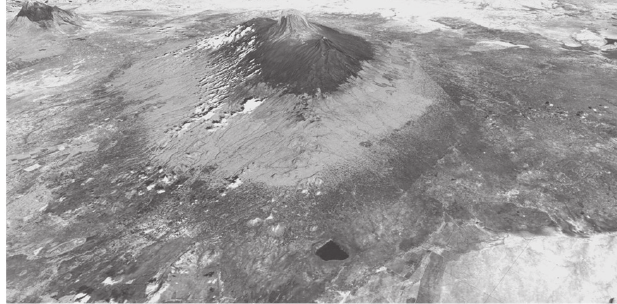
Figure 1. Lake Challa occupying a volcanic caldera, of 2.7 km diameter, at 840 m elevation on the lower east slope of Mt. Kilimanjaro, viewed from the southeast; gray shading reflect vegetation zones.